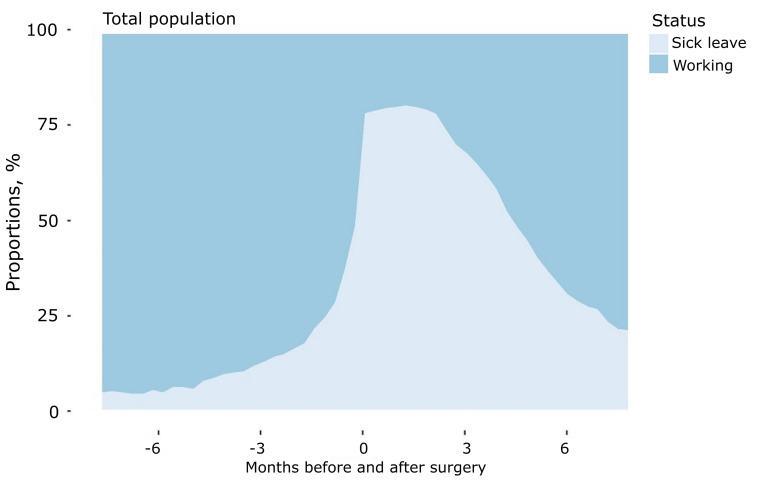
The proportional distribution of employment status six months before and after surgery among patients between 18–63 years.The figure illustrates the status of the patients at different time points before and after surgery. Status of patients who are part of the workforce and patients on sick leave are visualised.